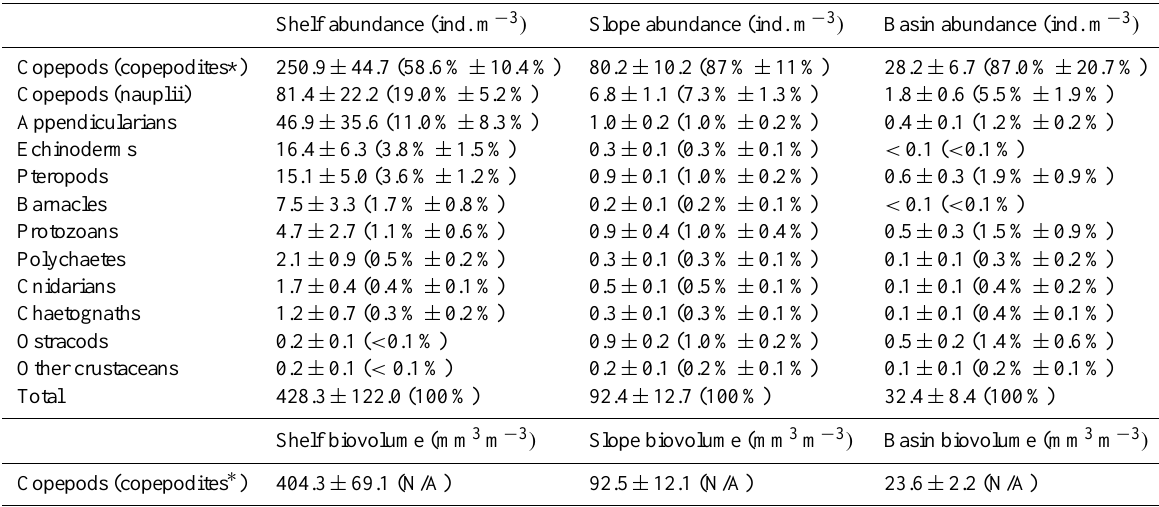
Table 3. Abundance of sorted zooplankton groups and biovolume of copepodites (including adults; mean ± SE and percent contribution in brackets) as identified by traditional taxonomic counts in samples from integrated vertical net tows (bottom to surface, 200µm mesh size) conducted in the shelf ( < 100m), slope (100–1000m) and basin ( > 1000m) regions of southeast Beaufort Sea in July–August 2009 (Fig. 1). The data presented in this table summarize the whole zooplankton net dataset comprising 29 vertical tows (Appendix A). The biovolume of copepodites was based on the morphometry of copepods for which species-specific body measurements were available (see Sect. 2.3). No morphometric estimates were attempted on other groups. N/A: not available.